Question: Sum up the contents of this chart in one sentence.
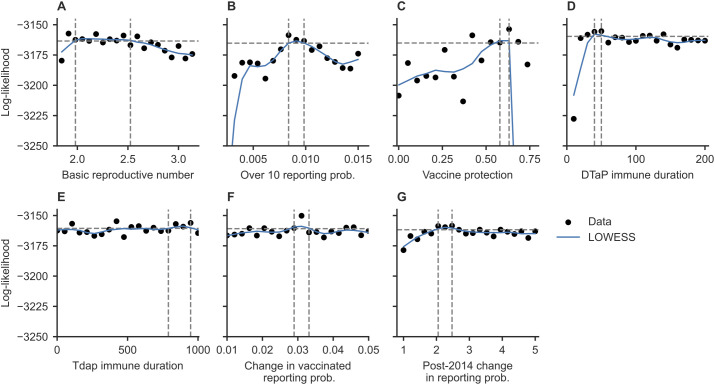
Answer: Estimated profile likelihood functions. A–G) Estimated profile likelihood function for the basic reproductive number (panel A), vaccine protection parameter (panel B), over-10 reporting probability (panel C), mean DTaP immune duration (panel D), mean Tdap immune duration (panel E), change in vaccinated reporting probability (panel F) and post-2014 change in reporting probability (panel G). Black points correspond to the estimated profile likelihood found by maximising the all unknown model parameters apart from the profiled parameter, which is fixed to the value shown. Blue lines are calculated using LOWESS smoothing and vertical grey lines indicate the bound of the 95% confidence interval. Our methodology was unable to reliably estimate Tdap immune duration.